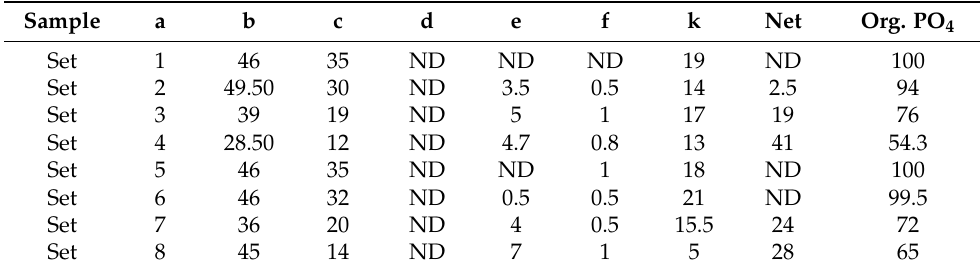
Scheme 1. The structures of various compounds discussed in the text. The labeling of the structures is also similar to that mentioned in the NMR figures and Tables 1 and 2. Glycerol monophosphates (red), inorganic phosphates (black), glycerol diphosphates (blue) and glycerol triphosphates (green), respectively. Table 2. Yields 1 (%) of the decomposition products of